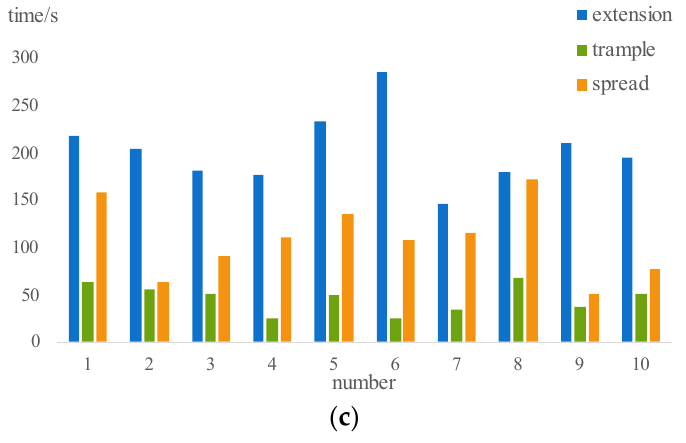
Figure 17. Histogram of occurrence time of behavior at different feeding densities. ( a ) time record of behavior occurrence during one duck in single cage feeding, ( b ) time record of behavior occurrence during two ducks in single cage feeding ( c ) time record of behavior occurrence during three ducks in single cage feeding.